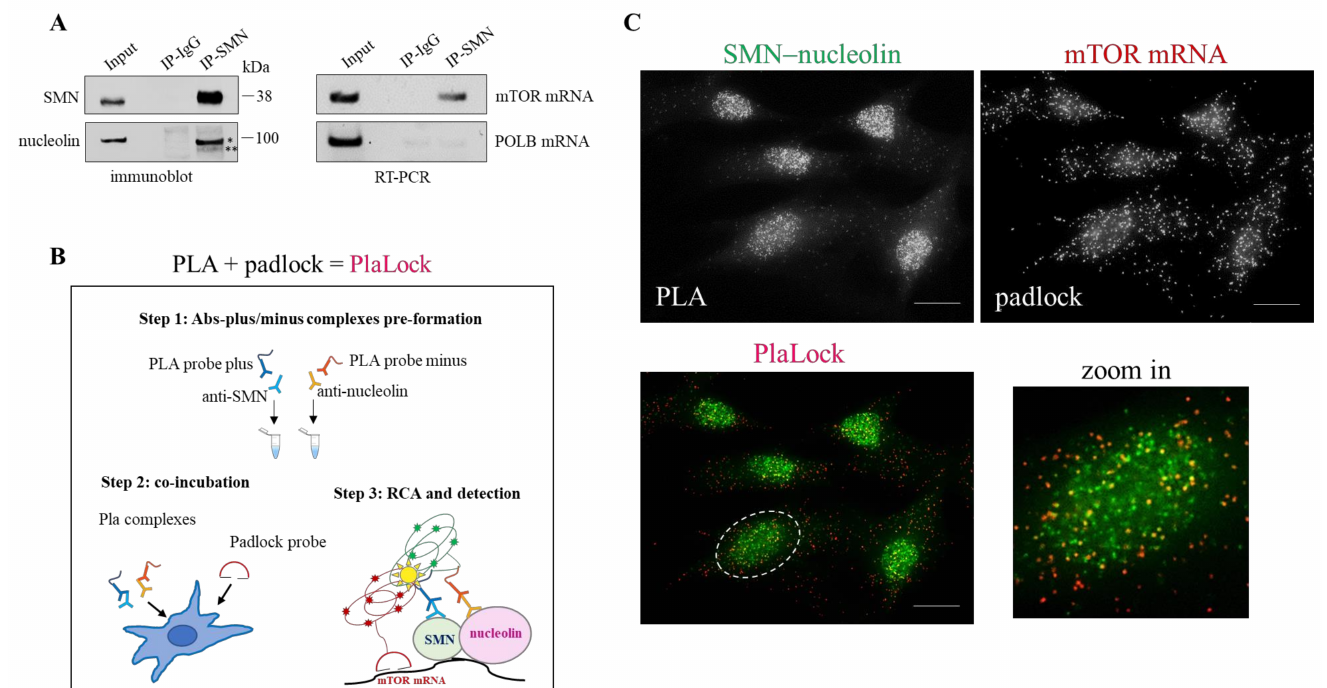
Figure 3. SMN coexists with nucleolin–mTOR mRNA complexes. ( A ) Cellular extracts from hTert-Fibroblasts were subjected to RNA-immunoprecipitation (RIP) assay. SMN monoclonal antibody-conjugated beads or mouse IgG-conjugated beads were used in immunoprecipitation steps. (left) Immunoblotting validating nucleolin co-precipitation with SMN. To note, anti-nucleolin antibody detects two bands: a main band of 100 kDa (*) and a faint, smaller band (**). (right) mTOR mRNA were checked in RIP samples by RT-PCR analysed by agarose gel electrophoresis. DNA Polymerase Beta (POLB) mRNA was monitored as control. Representative panels of n = 3 independent experiments. ( B ) Diagram illustrating the main experimental steps of the “PlaLock” assay in fixed cells. PlaLock assay was designed to combine the PLA and padlock methods in situ. In this way, it is possible to visualize the coexistence, at subcellular levels, of a selected mRNA with a specific protein–protein complex (see Methods section). ( C ) Representative images of a PlaLock performed in hTert-Fibroblasts. (right) SMN-nucleolin complexes visualized by PLA. (left) Subcellular distribution of mTOR mRNA by padlock. The bottom panel visualizes the merged images. mTOR mRNA and SMN-nucleolin complexes are labelled in red and green, respectively. Yellow dots are mostly detectable in nuclear regions, as illustrated in the higher magnification of the white dotted circle region (zoom in). Scale bar 5 µ